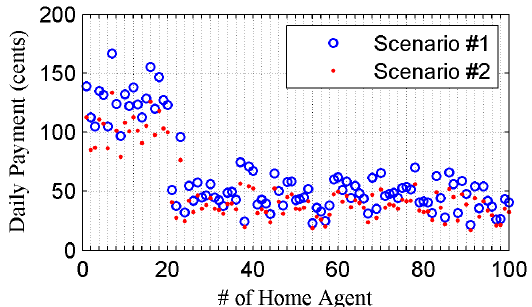
Figure 3. Electrical energy cost of 100 homes.